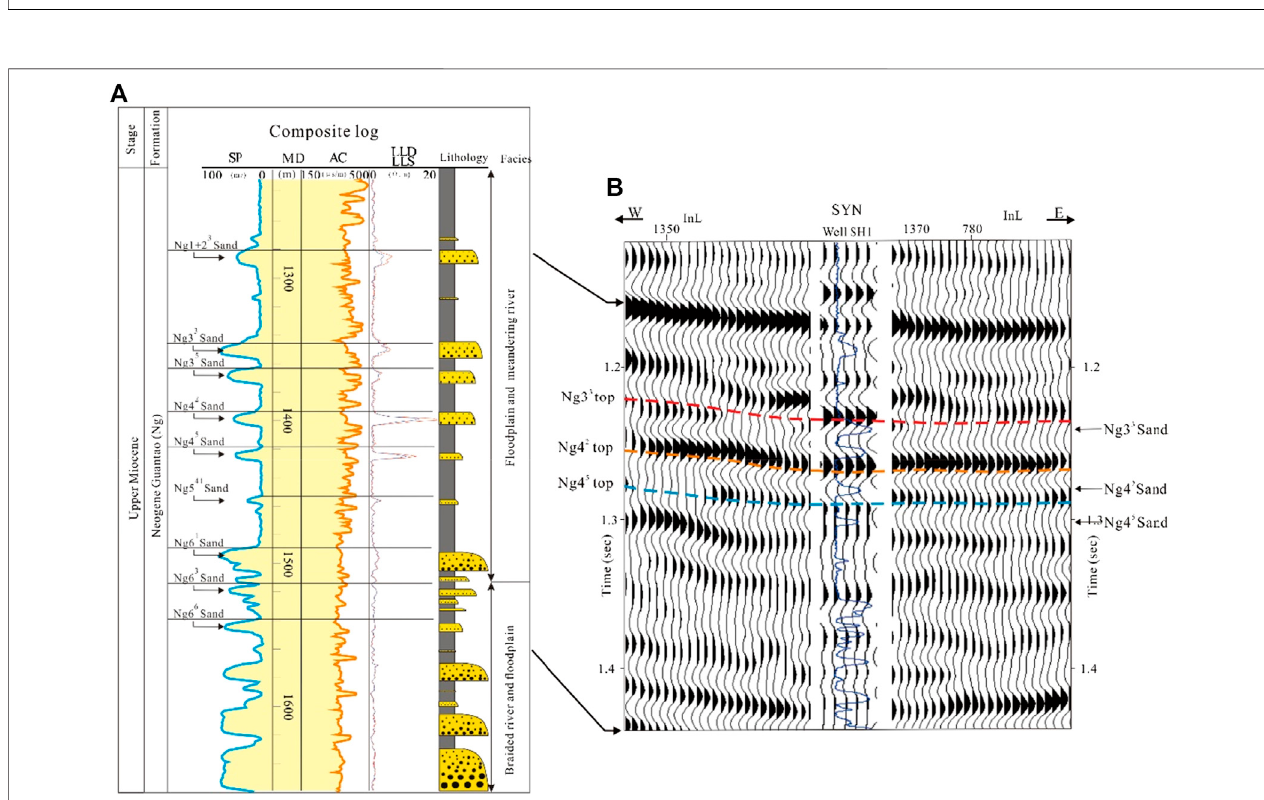
FIGURE 2 | Wireline-log and seismic characteristics of the target layer of the Upper Guantao Formation. (A) Wireline-log shows that the sand content of the lower GuantaoFormationishighanddominatedbybraidedfacies(Gaoetal.,1997),whilethesandcontentoftheupperGuantaoFormationislow. (B) Seismicpro fi lethatwas converted by the − 90 ° phase shows that the sandstones of Ng33, Ng42, and Ng55 sub-layers are located in the wave trough, and that the sand body is stable over a small range.